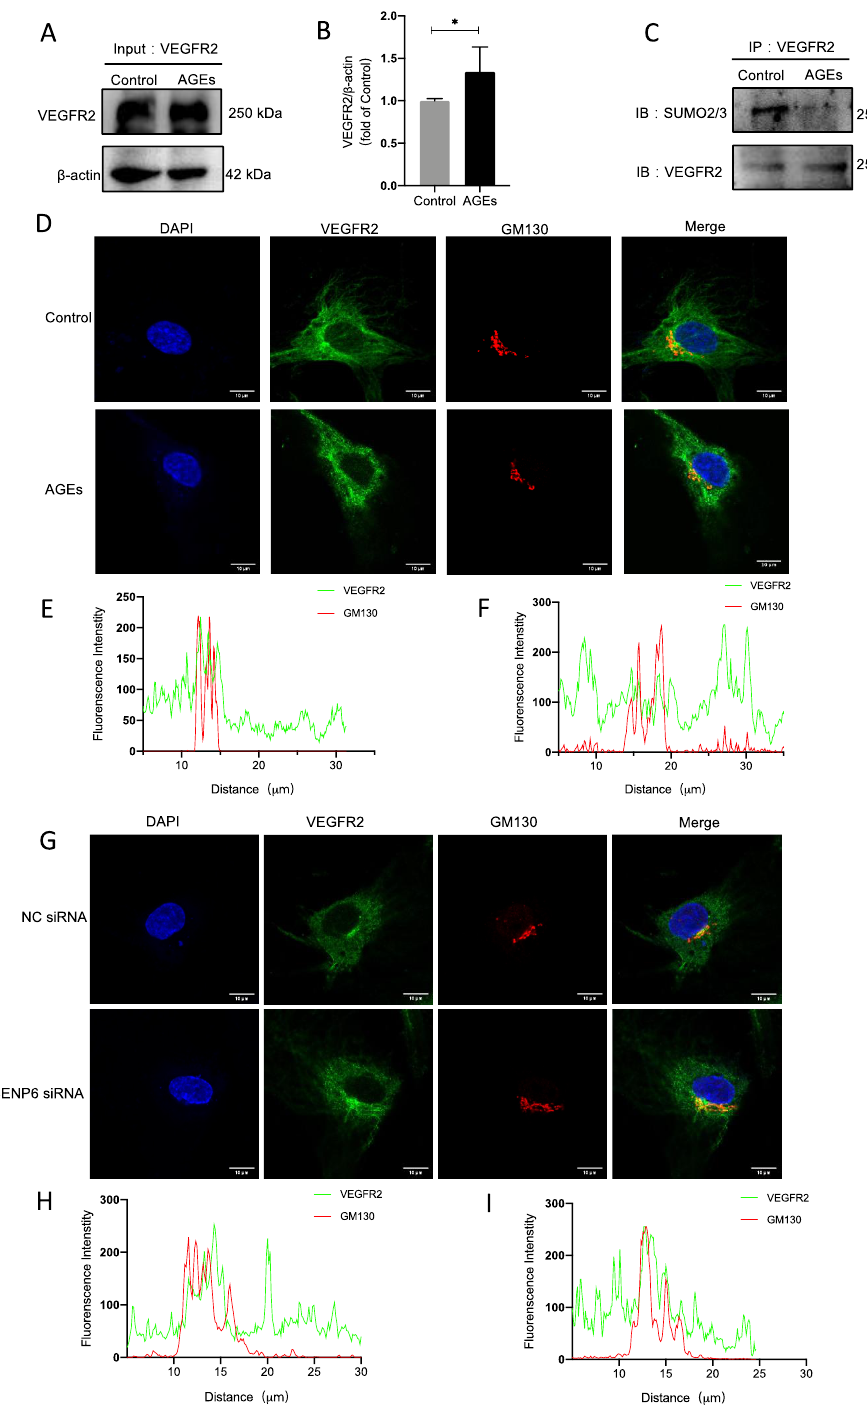
Figure 4. VEGFR2 SUMOylation retains VEGFR2 in the Golgi. ( A ) The total protein indicated in VEGFR2 cell lysates was determined by Western blot. ( B ) Analysis of protein expression level results, n = 7, * p < 0.05 vs. control. ( C ) The effects of AGEs on the SUMOylation of VEGFR2 were detected by Co-IP followed by Western blot analysis, n = 5. ( D ) Immunofluorescence staining, VEGFR2 (green), GM130 (red), nucleus (blue), n = 3, Scale bar: 10 µ m. ( E , F ) The green and red fluorescence density and localized distance were measured, ( E ): control, ( F ): AGEs. ( G ) Immunofluorescence staining, VEGFR2 (green), GM130 (red), nucleus (blue), n = 3, Scale bar: 10 µ m. ( H , I ) The green and red fluorescence density and localized distance were measured, ( H ): NC siRNA, ( I ): SENP6 siRNA. * indicates significance between the indicated